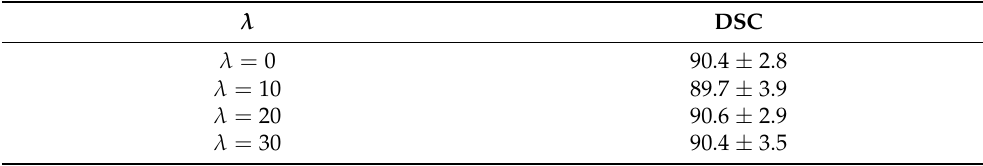
Table 7. Segmentation results for different values of λ for our contour-aware CNN based on nn-UNet for the CHAOS dataset in DSC (%).